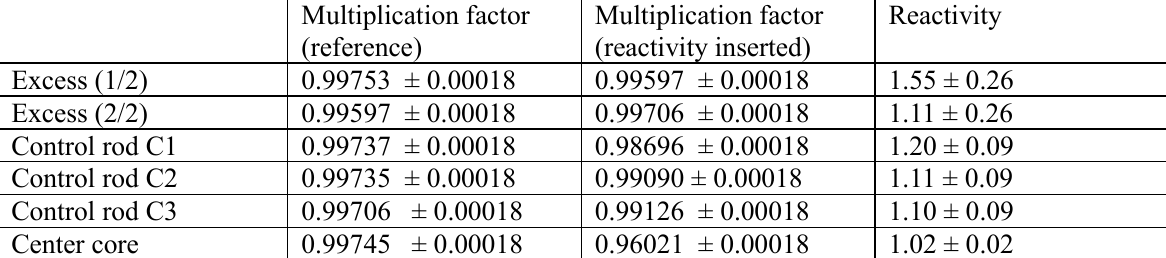
Table IV. C/E value of multiplication factor and reactivity with JENDL 4.0: Errors correspond to 2σ